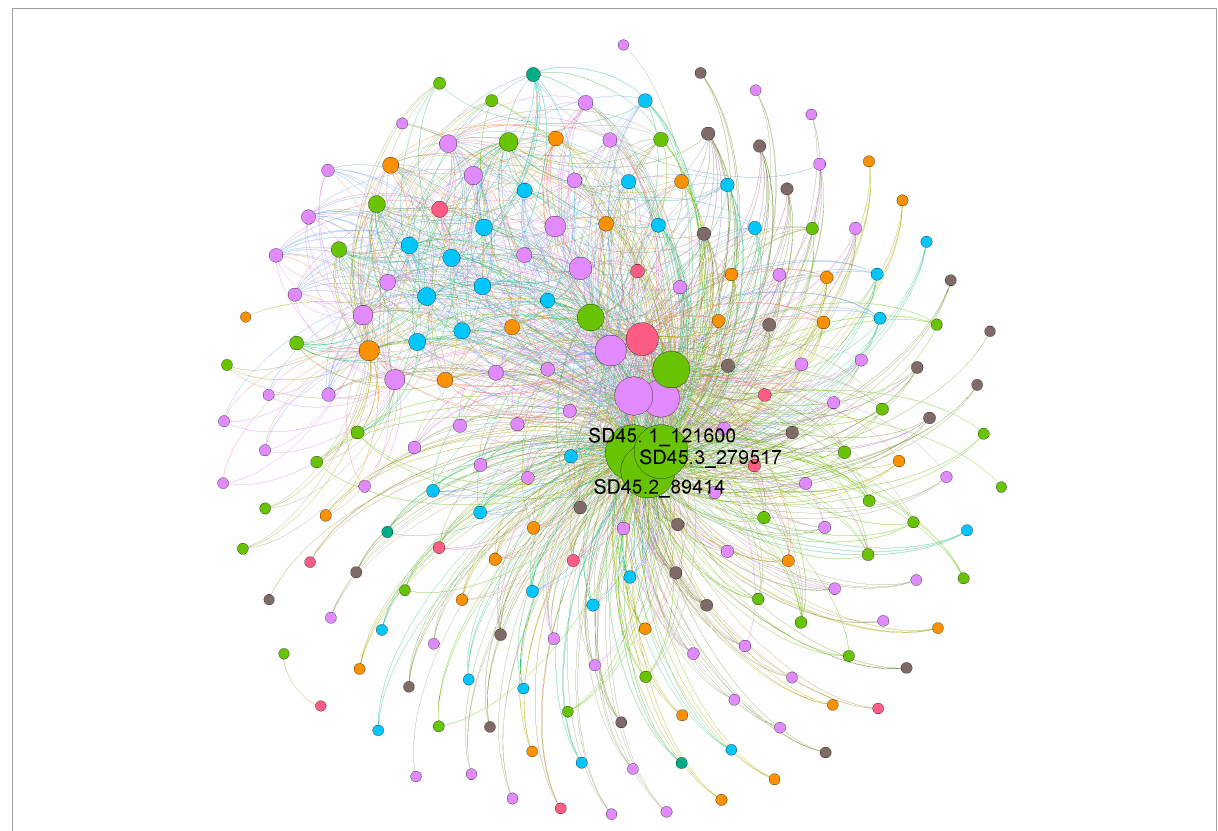
FIGURE5 The coexpression of genes in the black module. Based on the similarity between genes in the key module, the module network was constructed, and the core genes were screened. Different colors represent genes from different samples, and the size of the circle represents the